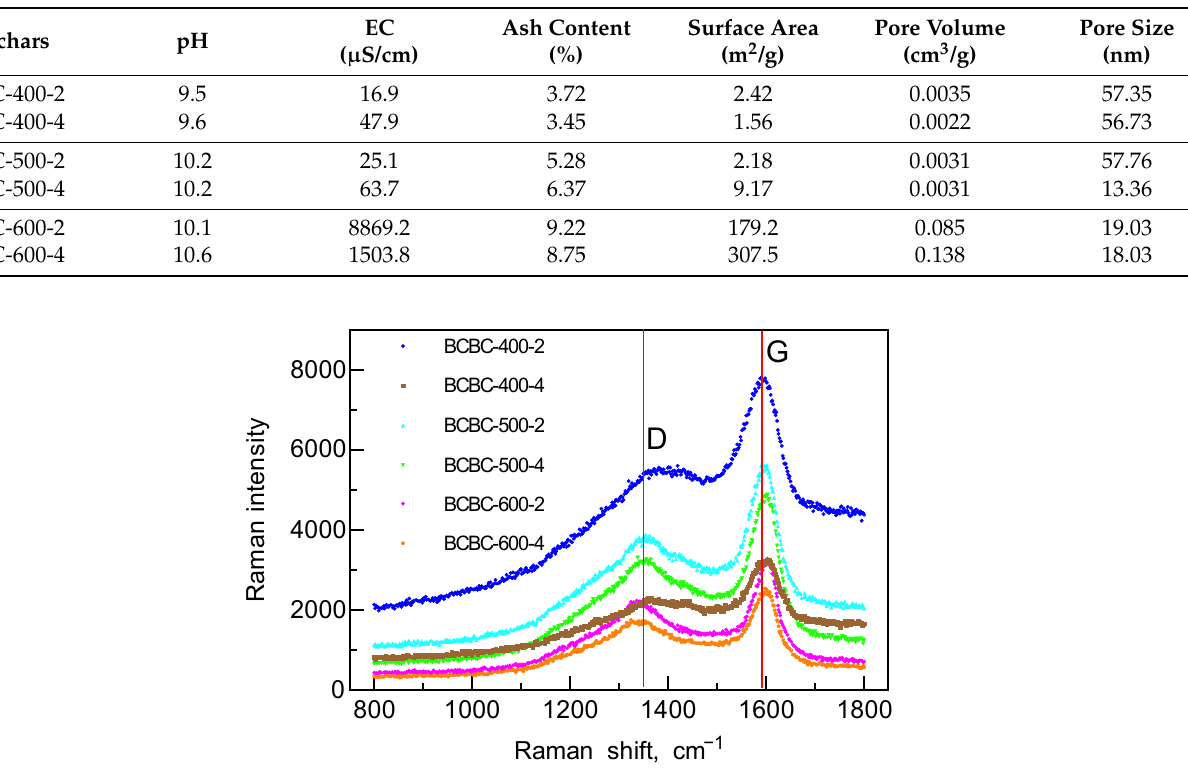
Table 2. pH, electrical conductivity (EC), ash content, BET surface area, pore volume, and pore size of biochars produced at different conditions.